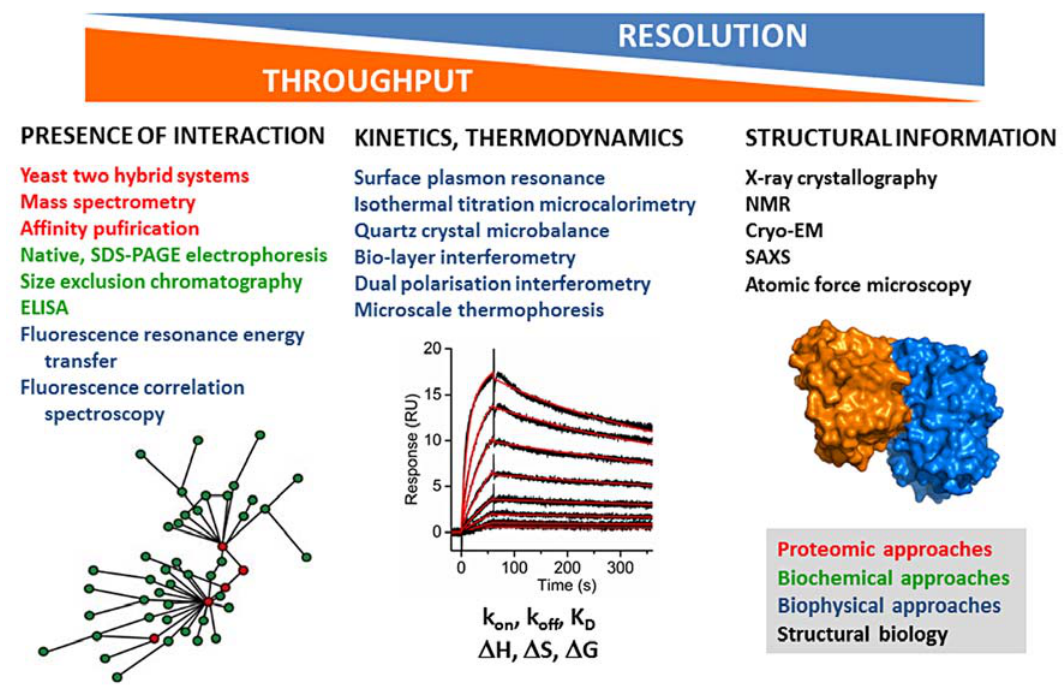
Figure 1. Methods for studying protein-protein interactions by throughput and information content. Some of the most commonly used methods for analysing protein-related interactions are listed. Typical data are presented for each methods